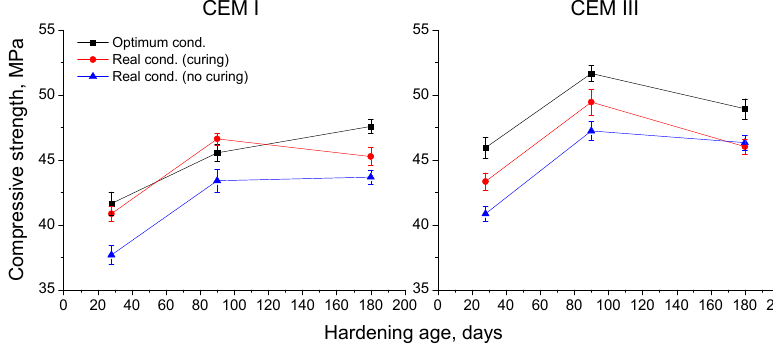
Figure 11. Results of compressive strength for concretes prepared using CEM I and CEM III respectively.